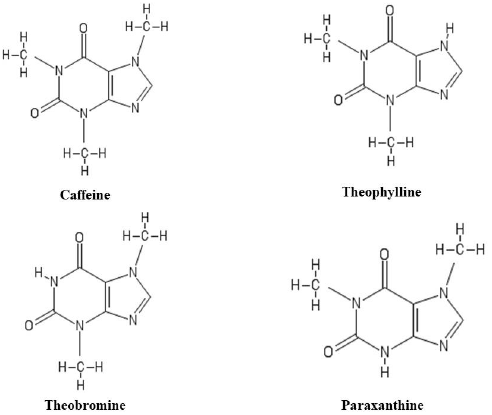
Figure 1. Chemical structure of ca ff eine and its three metabolites: theophylline, theobromine and